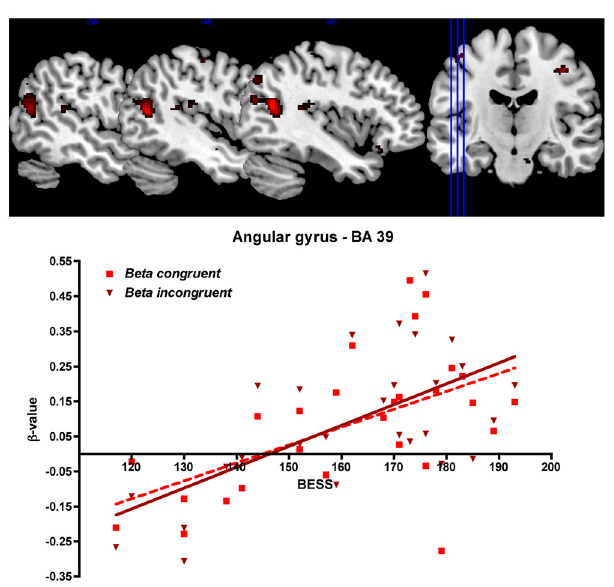
FIGURE 6 | Top : Cortical activation related to language ability. The figure shows cortical activation in the left angular gyrus/temporal lobe during congruent sentence reading that was correlated to high-level language ability measured as high performance on the BeSS test. For visualization purposes, the threshold is set to p < 0.001 uncorrected in this image. Statistical data of the significant, corrected results are shown in Table 2 . Bottom : Correlation between BeSS scores and the mean beta values (parametric estimates) from the region of interest encompassing left angular gyrus (for congruent respective incongruent sentence